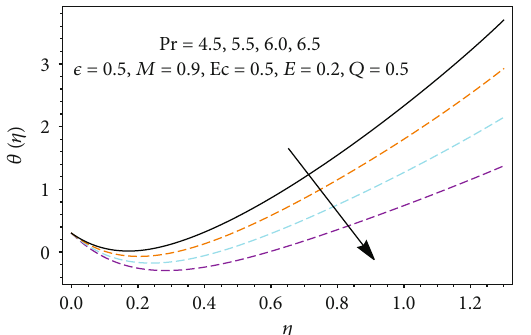
Figure 9: Illustration of the in fl uence of the input factor Pr on θ ð η Þ . Table 3: Impact of di ff erent input factors on skin friction ½ R C ð μ / μ f Þ f ″ ð 0 Þ . f = hnf